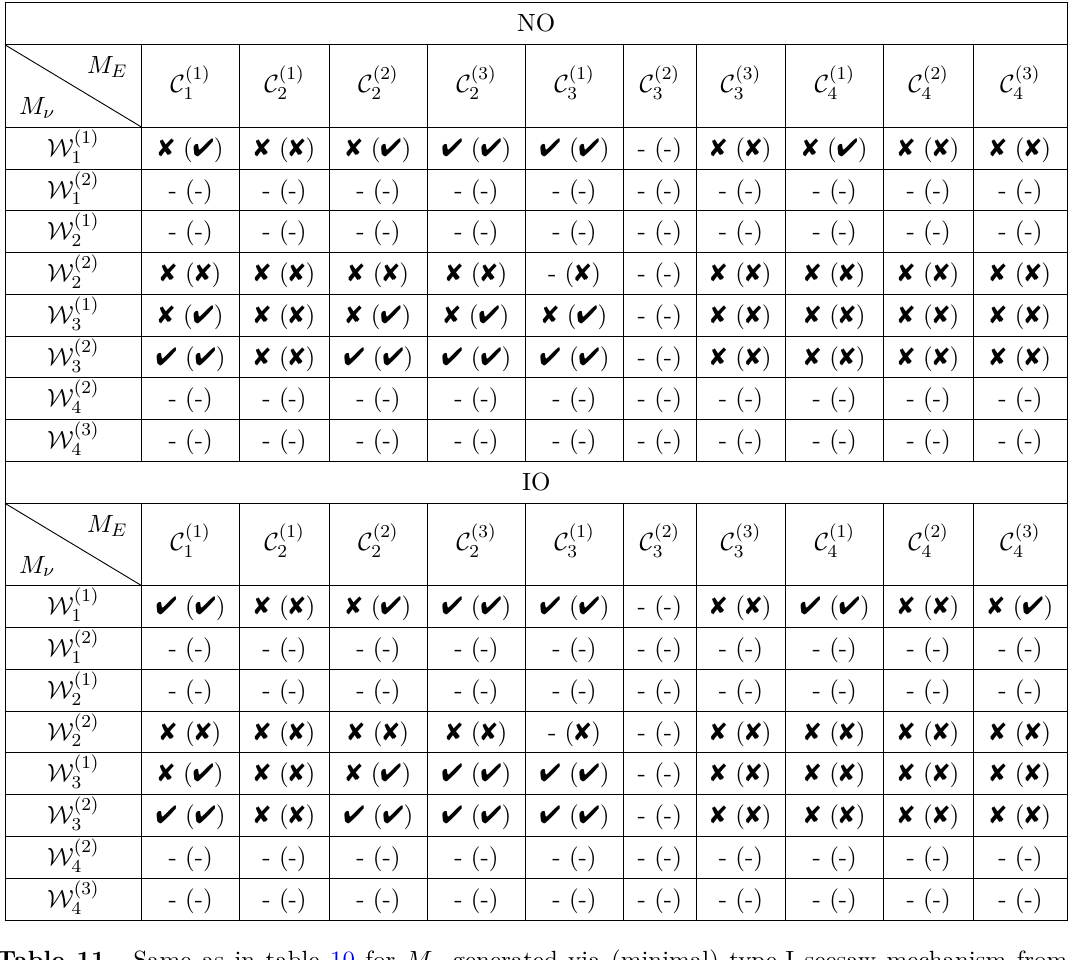
Table 11. Same as in table 10 for M ν generated via (minimal) type-I seesaw mechanism from M D and M N textures given in (4.22) and (4.21), respectively. The ( M D , M N ) → M ν dictionary is provided in table